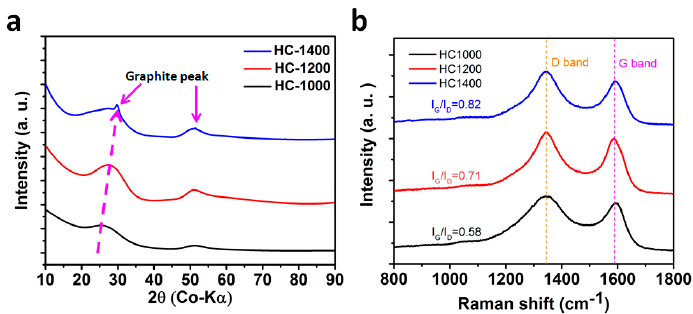
Figure 1. Structure analysis of hard carbon (HC) obtained under different conditions. ( a ) X-ray diffraction (XRD) patterns and ( b ) Raman spectra normalized by the peak height of the G band of HC carbonized at temperatures of 1000 °C, 1200 °C, and 1400 °C.